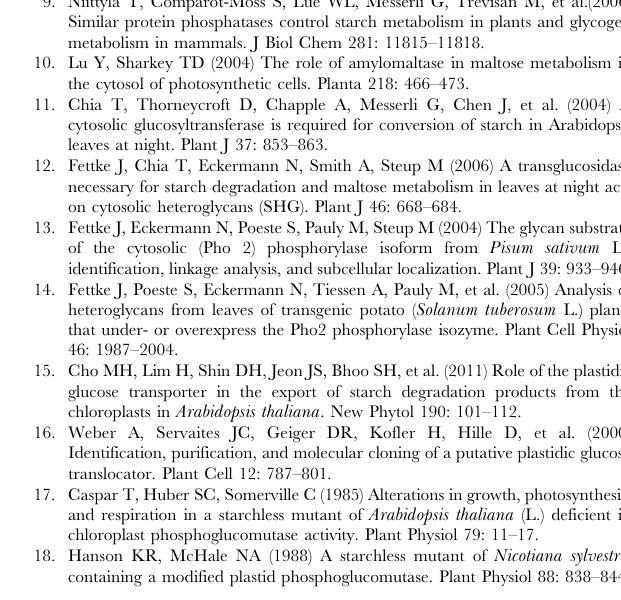
qPCR analysis. Table S2 . Chlorophyll content of Col-0 and pgm2/3 plants. Table S3. Values of the metabolic profiling used for the generation of the heat map. Figure S1 . Phosphogluco- mutase activity in Arabidopsis leaves. Figure S2. Analysis of single knock-out lines pgm2 and pgm3 and Col-0 under long day conditions (14 h light/10 h dark). Figure S3. Characterization of Col-0 and pgm2/3 plants. Figure S4. Growth phenotypes of Col- activity in Col-0 and PGM transgenic